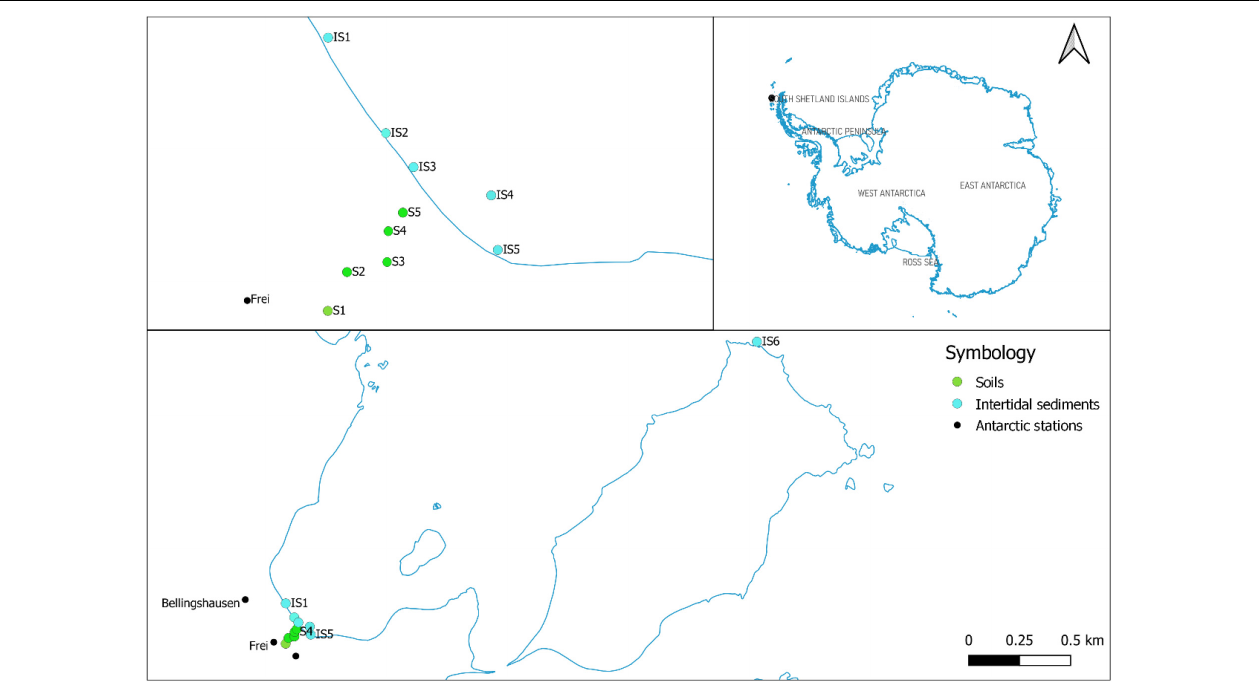
FIGURE 1 | Sampling areas on Fildes Bay and Ardley Island, Antarctica. Green points indicate soil samples (i.e., S1–S5), and light blue points represent intertidal sediments (i.e.,